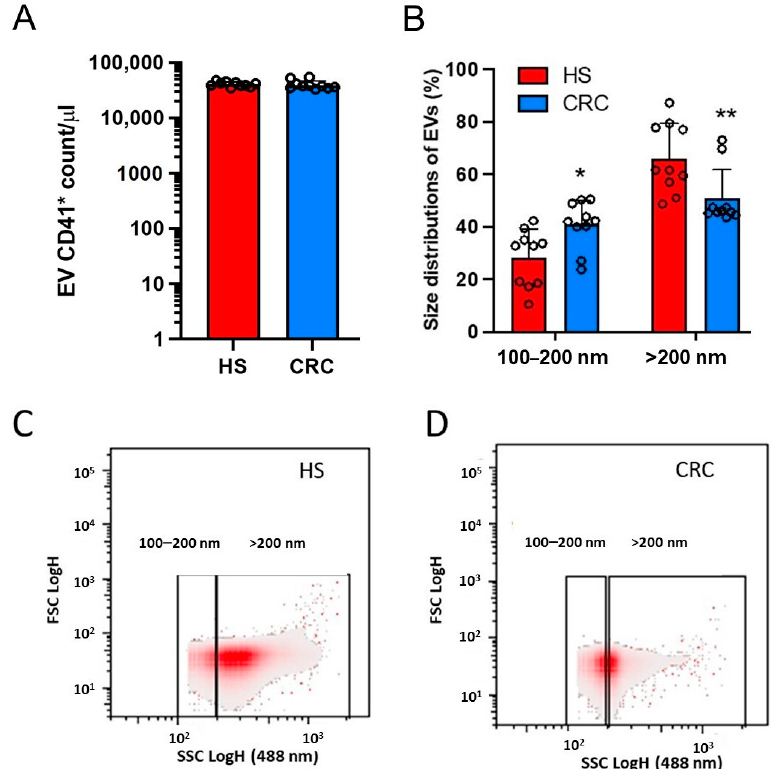
Figure 2. Count and features of mEVs released from thrombin-stimulated platelets of HS and CRC patients. Medium-sized EVs were obtained from washed platelets incubated with CaCl 2 (2 mM) and thrombin (1U/mL) for 30 min at 37 ◦ C in the water bath and then by centrifugation at 20,000 × g for 40 min at 4 °C. ( A ) The count of mEV CD41 + in HS and CRC patients is shown and performed by flow cytometry (FACSVerse, BD Biosciences), as reported in the material and methods; the values were transformed to logarithms, and all values are shown as scatter dot plots with mean + SD. ( B ) The size distribution of EV suspensions obtained from thrombin-activated platelets of HS and CRC patients is reported as % EVs with a diameter of 100–200 nm and >200 nm; all values are shown as scatter dot plots with mean + SD and analyzed by two-way ANOVA and Sidak multiple comparison test; * p < 0.05, ** p < 0.01 vs. HS. ( C , D ) Density plots of forward scatter height (FSC-H) vs. side scatter height (SSC-H) of a typical EV suspension from HS and CRC patients, respectively; the rectangular describes the diameter range (nm) of EVs based on SSC (488 nm). FSC detects scatter along the path of the laser, and SSC measures scatter at a ninety-degree angle relative to the laser.